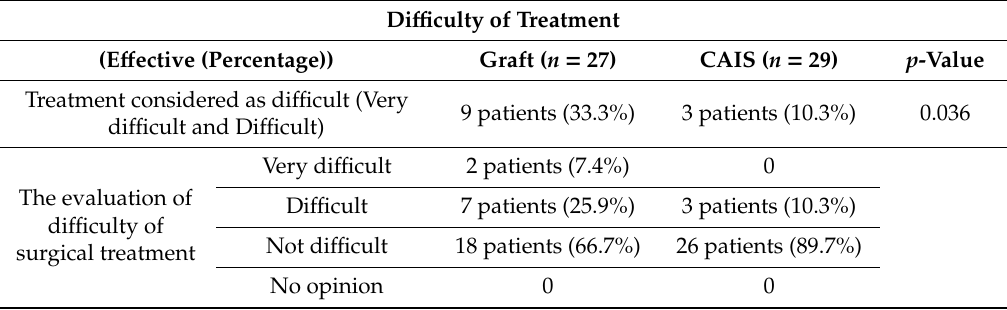
Table 5. Di ffi culty of